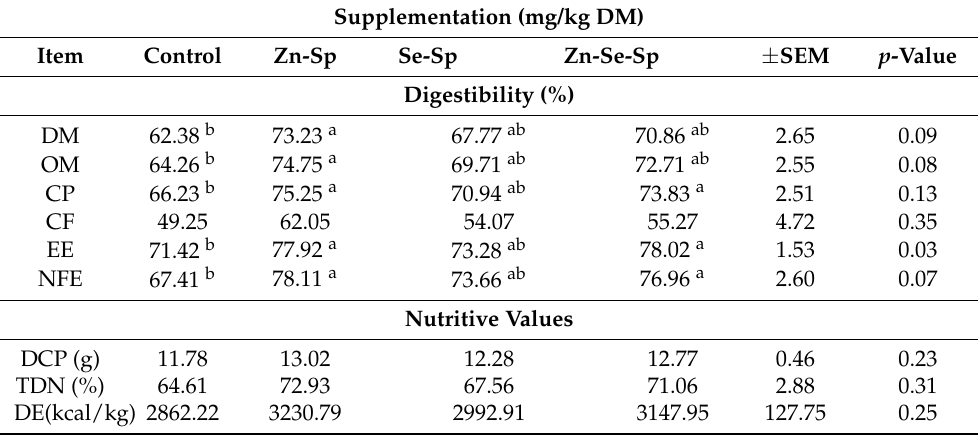
Table 3. Effect of dietary supplemental Zn-Sp, Se-algae and their combination on digestibility and nutritive value of experimental rabbit